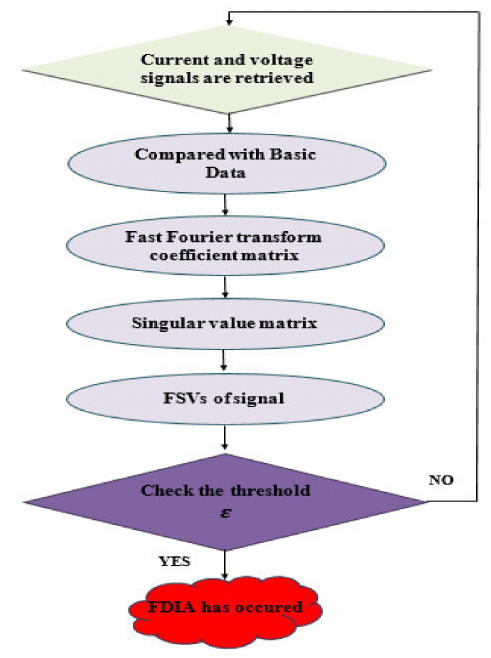
Figure 1. Proposed FDIA detection